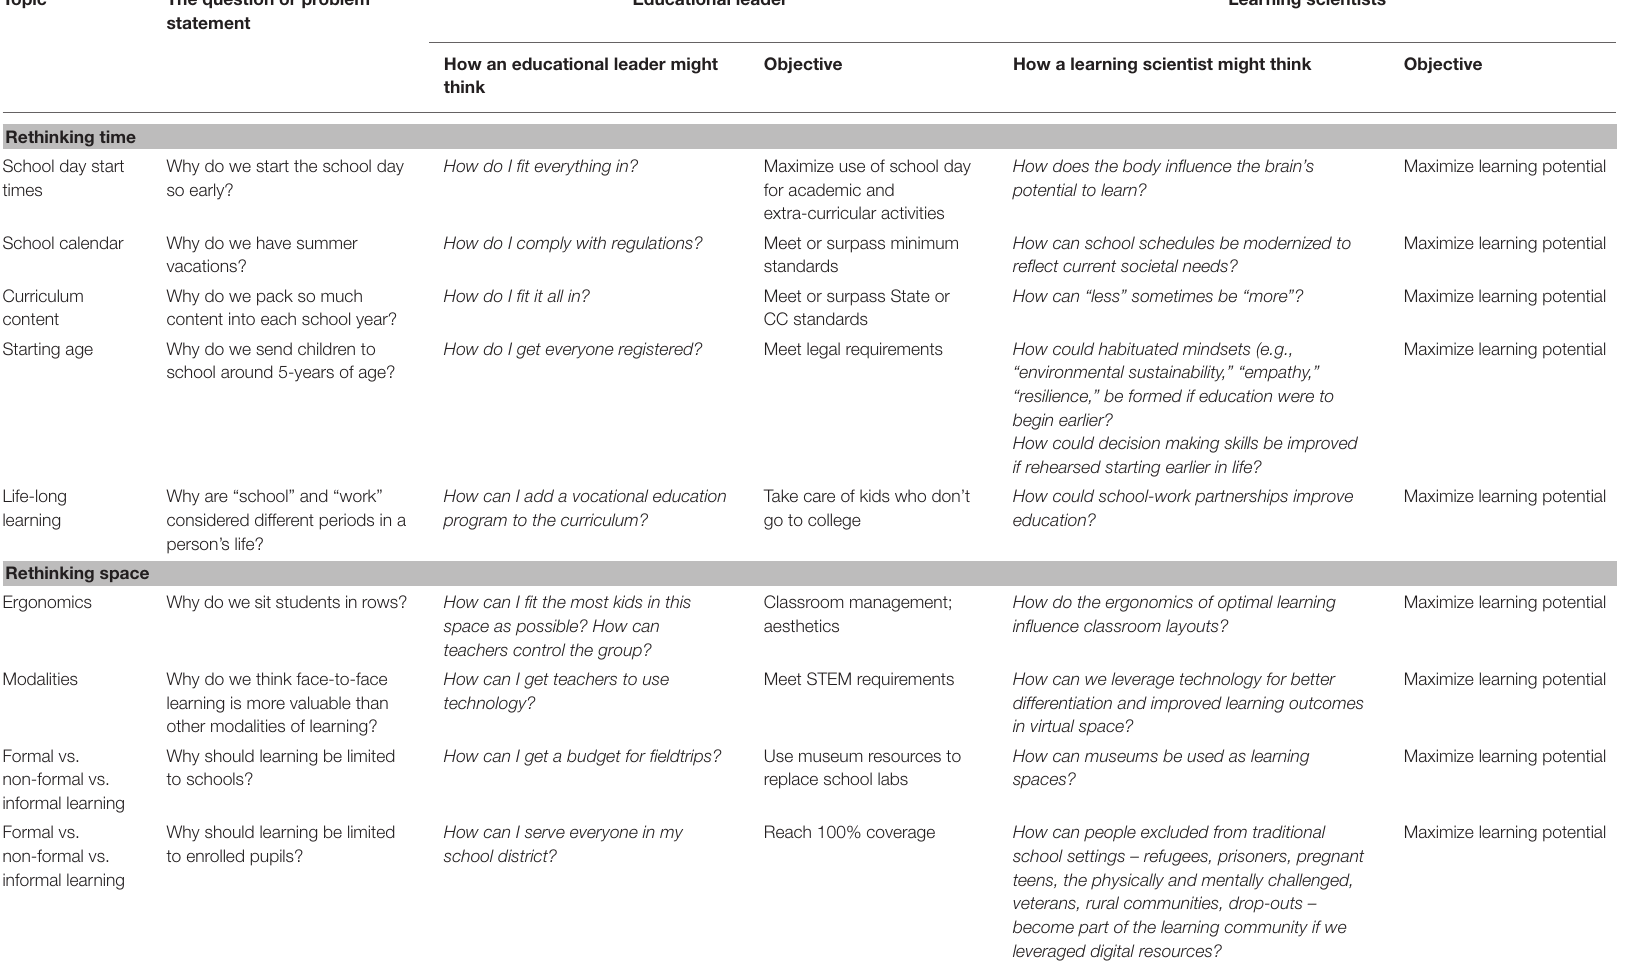
TABLE 1 | How decisions in education would look if mind, brain, and education scientists ran schools.